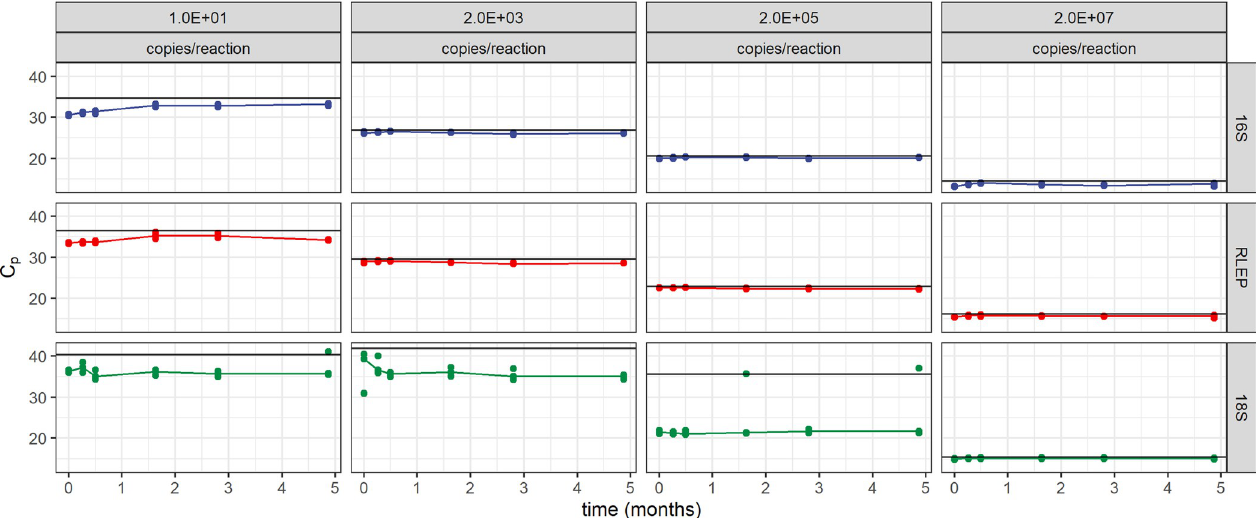
Fig 4. Stability of the reactions over five months using synthetic DNA as a template. Each panel shows the C p values obtained for each target (lines of panels) and for each template concentration (columns of panels) over time. Points represent one technical replicate. Black horizontal lines indicate the upper tolerance limit defined as three standard deviations above the mean C p for each template